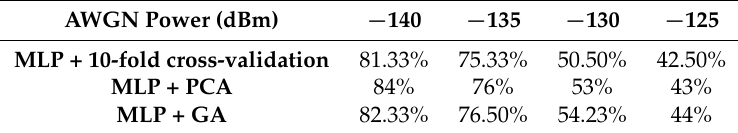
Table 11. ML-based prediction results for